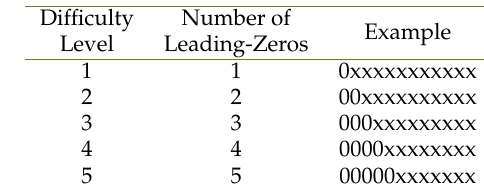
Fig. 4. Proposed Blockchain Structure. Table 3. Difficulty Level Setting